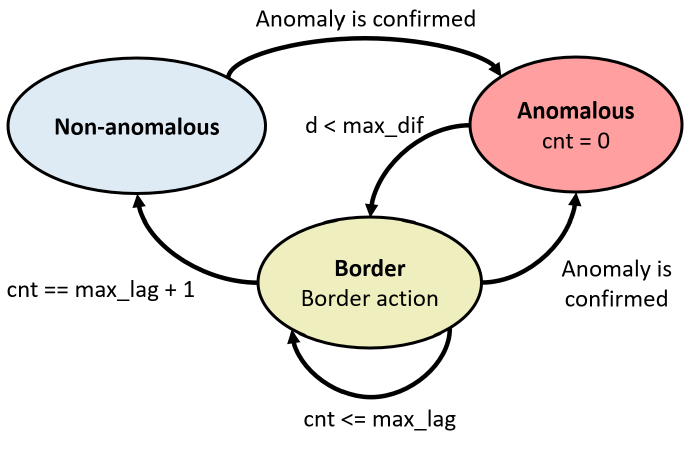
Figure 2. State machine.